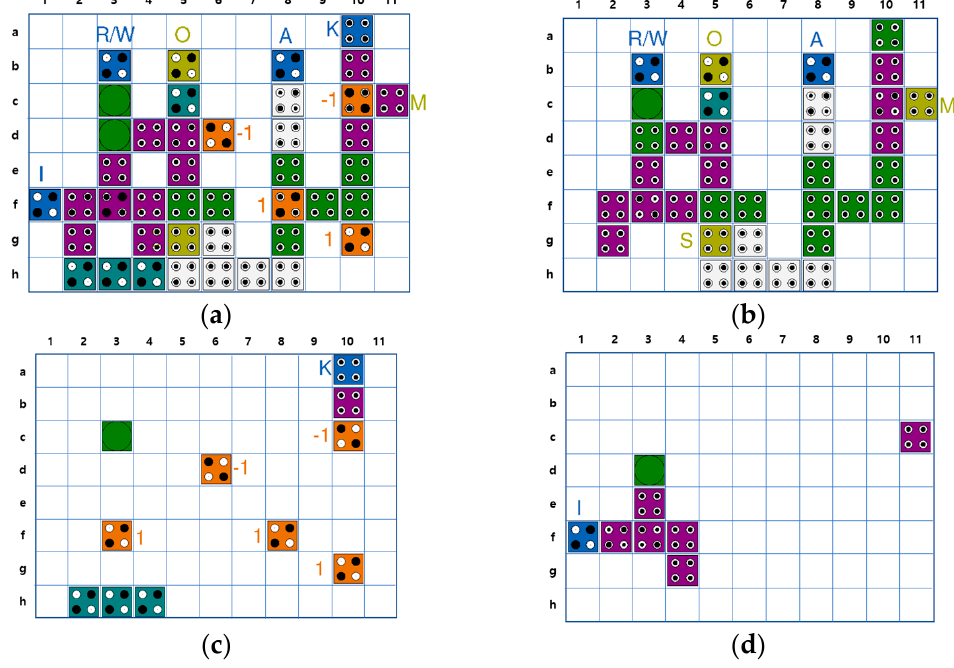
Figure 11. Proposed QCA CAM cell: ( a ) All layer; ( b ) Layer 1; ( c ) Layer 2; ( d ) Layer 3.